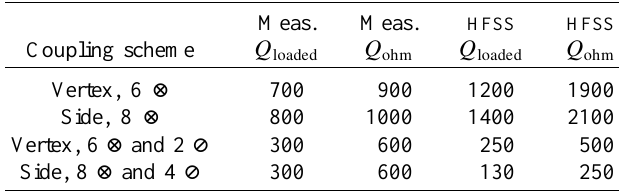
TABLE II. Measured and HFSS simulated Q factors for differ- ent coupling schemes. ≠ are missing rods and Æ are the partially withdrawn rods.